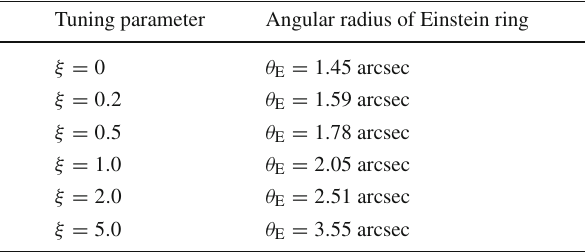
Table 2 Einstein ring of acoustic Schwarzschild black hole. The angu- lar radii θ E of Einstein ring are presented for several tuning parameter ξ . In this table, the mass of acoustic Schwarzschild black hole is set as M = 4 . 3 × 10 6 M (cid:16) , and the distances between observer O , lens plane and source plane are chosen to be D LS = D OS = 8 . 3 kpc. In this table, we have excluded the unphysical solutions of Einstein ring θ E (namely when θ E gets complex values or negative real values) Tuning parameter Angular radius of Einstein